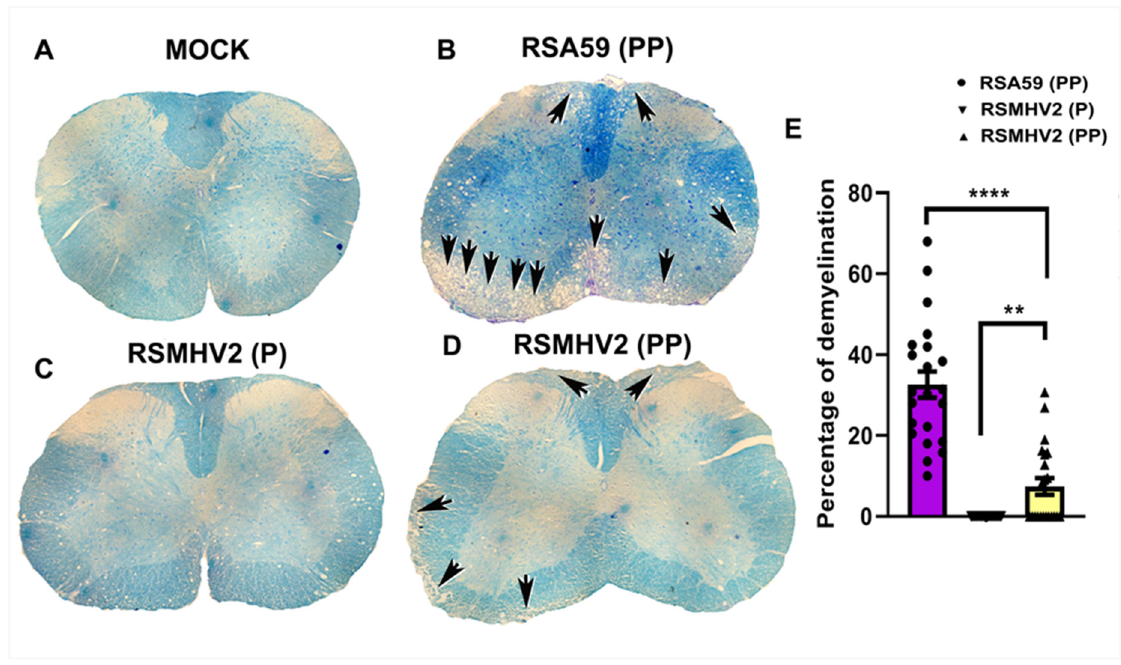
Figure 9. Presence of double proline in the FP of RSMHV2 (PP) induces sparse myelin loss during day 30 p.i. (chronic stage of infection) . Five to ten-micron thick spinal cord sections from either mock-infected ( A ) or RSA59 (PP) ( B ), RSMHV2 (P) ( C ), RSMHV2 (PP) ( D ) infected mice were stained with LFB to detect myelin loss. No myelin loss was observed in mock-infected or RSMHV2 (P) infected spinal cord sections ( A , C ), respectively. In contrast, large demyelinating plaques were observed at multiple levels of the spinal cord from RSA59 (PP) infected mice ( B ). RSMHV2 (PP) infected mice showed discrete yet fewer demyelinating axons without any obvious demyelinating plaques in sections of the spinal cord ( D ) (Black arrows indicate demyelinated area). Quantification of demyelination was plotted in the scatter-bar diagram ( E ), and the level of significance was calculated by unpaired Student’s t -test. N = 5 mice per virus infection. ** p < 0.001; **** p <